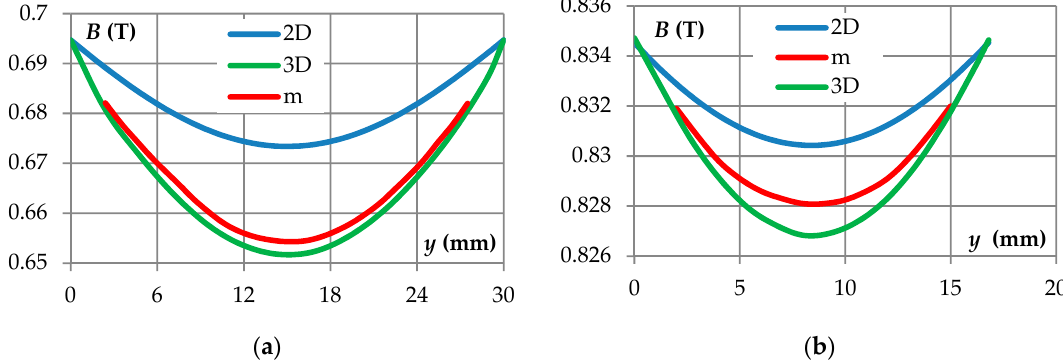
Figure 12. The magnetic flux density distributions between the magnets in the middle of the magnet length (0.5 L m ) along the y -axis for: ( a ) δ = 30 mm and ( b ) δ = 16.8 mm measured (m) and calculated using 2D and 3D models of the phenomena.